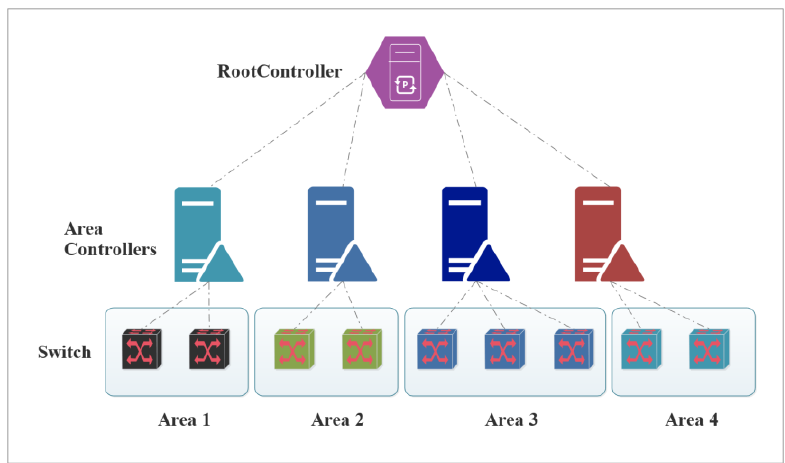
Figure 1. Control plane of the two-layer structure. Table 2. Important